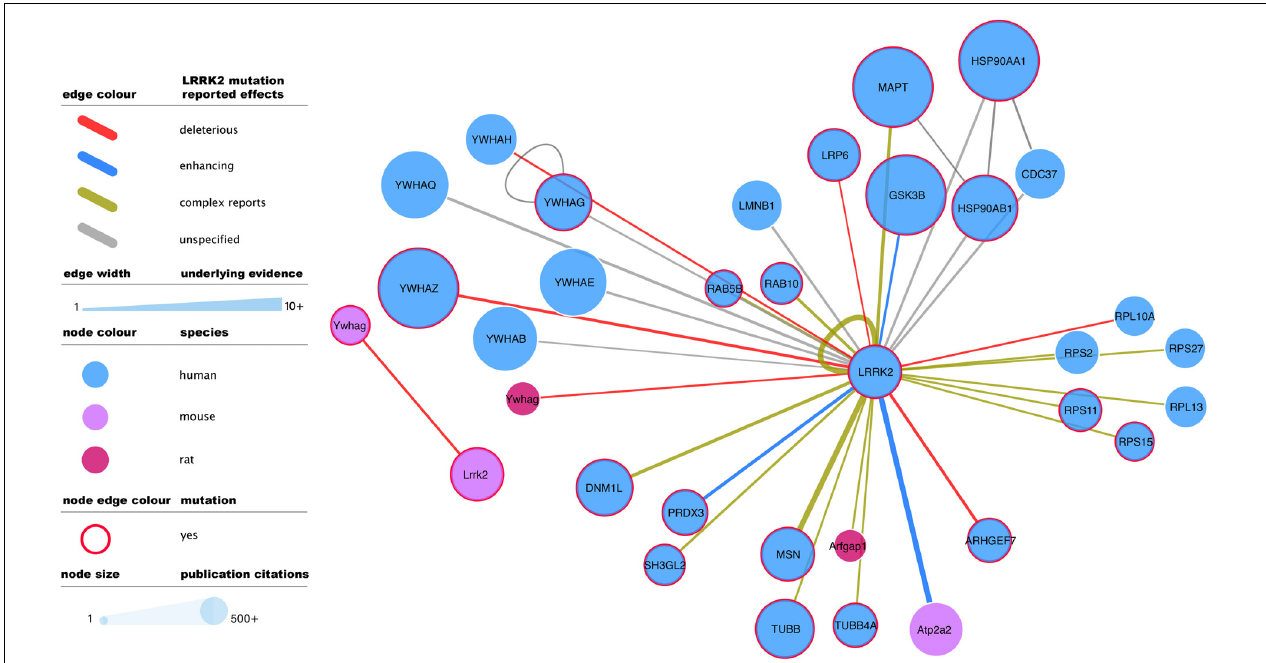
FIGURE 3 | Mutagenesis-tested LRRK2 high-confidence interactors as reported in IntAct. Edges represent composite of multiple interaction evidence where a LRRK2 mutation has been tested. Reported effects have been collated and simplified from their original designation following the PSI-MI controlled vocabulary “mutation” branch (www.ebi.ac.uk/ols/ontologies/mi/terms?iri=http://purl.obolibrary.org/obo/MI_0118). The simplified nomenclature uses “deleterious” if they impair the interaction, “enhancing” if they cause or strengthen it, and ‘complex reports’ if there are conflicting reports on mutation effect or there are different mutations with different effects over the same interaction. “unspecified” effects are those where the evidence does not allow to infer a consequence in comparison to the wild type version of LRRK2. For the rest of the visual features, see in-figure legend and figure 1 legend. An interactive and downloadable version of this network can be found at